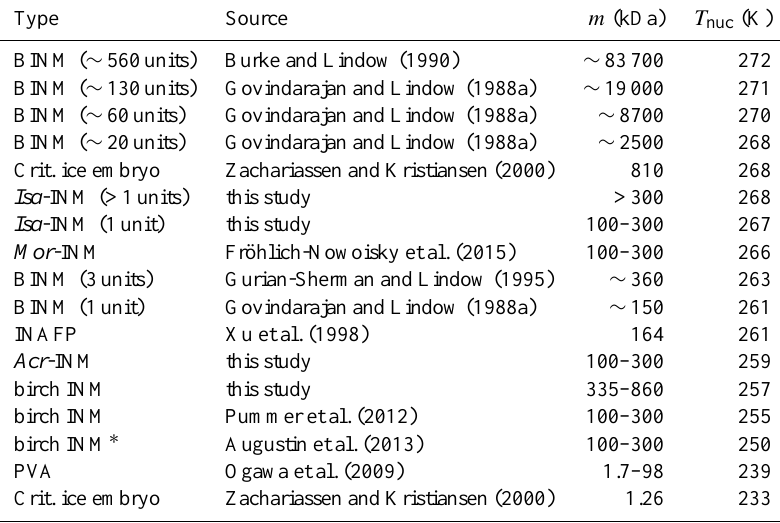
Table 3. Overview over masses ( m ) and activation temperatures ( T nuc ) of certain IN. Type